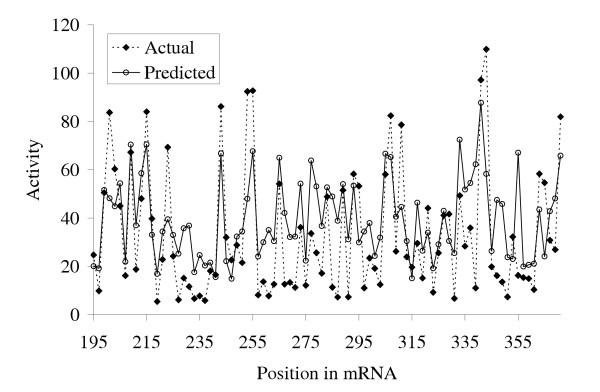
The profile of predicted (this study) and experimentally determined activities [1] for sliding window of 19 bases along human cyclophilin B (hCyPB) mRNA target sequence (GenBank accession number: M60857).